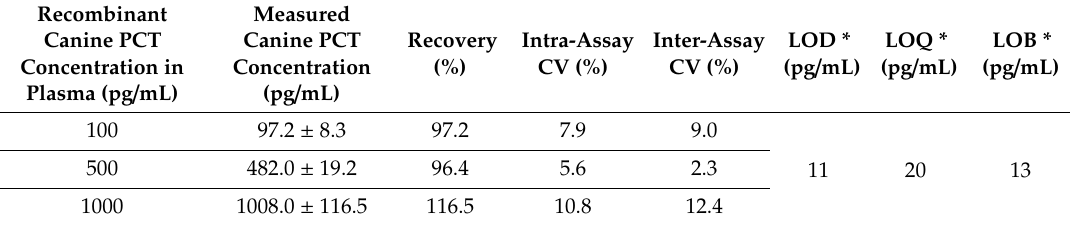
Table 3. Validation parameters of the rcPCT ELISA kit obtained in the plasma samples spiked